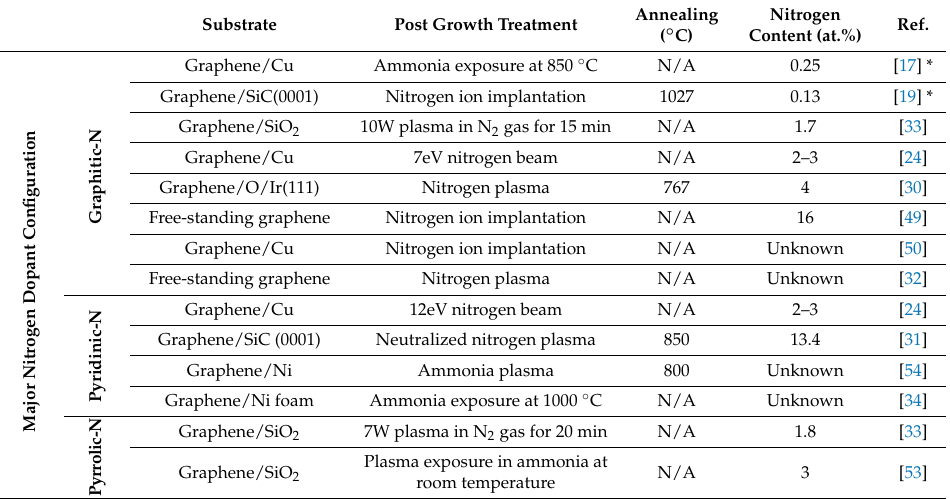
Table 2. Post-growth treatment NG preparation method and associated dopant bonding configuration.